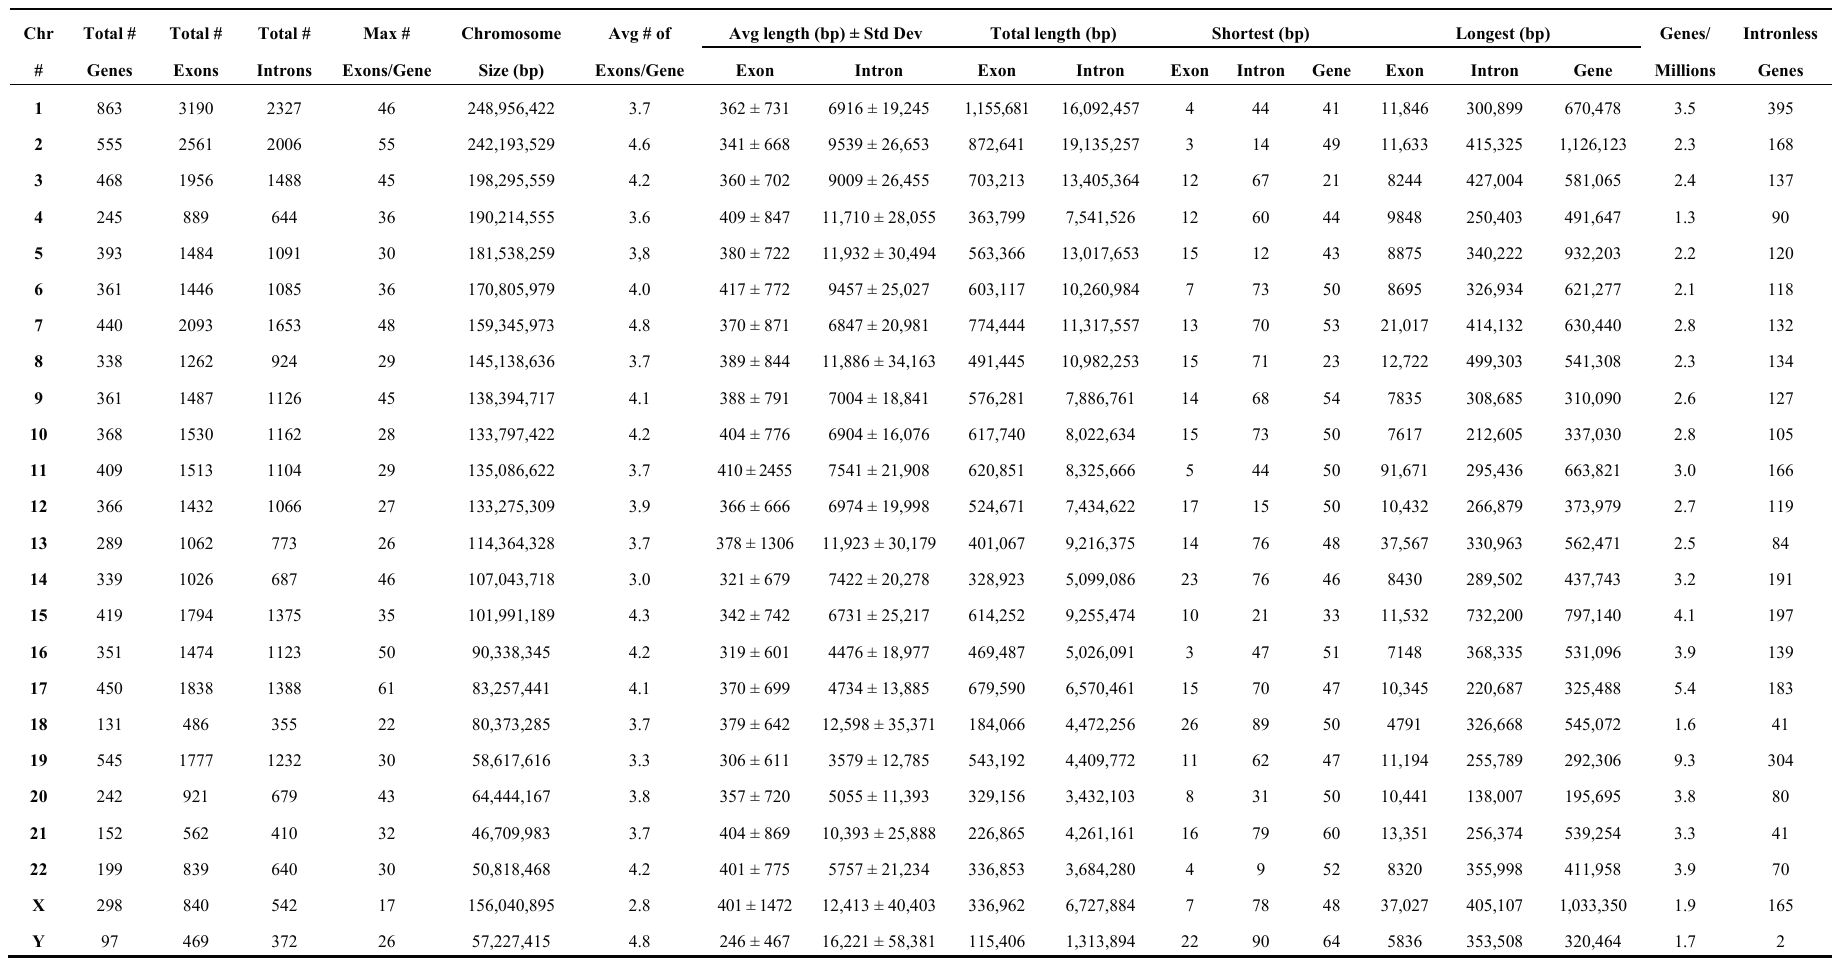
Table 3. Exons and introns distribution across human non-coding genes. Human genome data was downloaded from the UCSC main table browser (GCRh38, December 2013 build). Data was processed using tabular software. Analysis was performed using 8679 non-coding genes containing 33,931 exons and 25,252 introns. See the caution in Table 1 for the shortest introns (<30–40